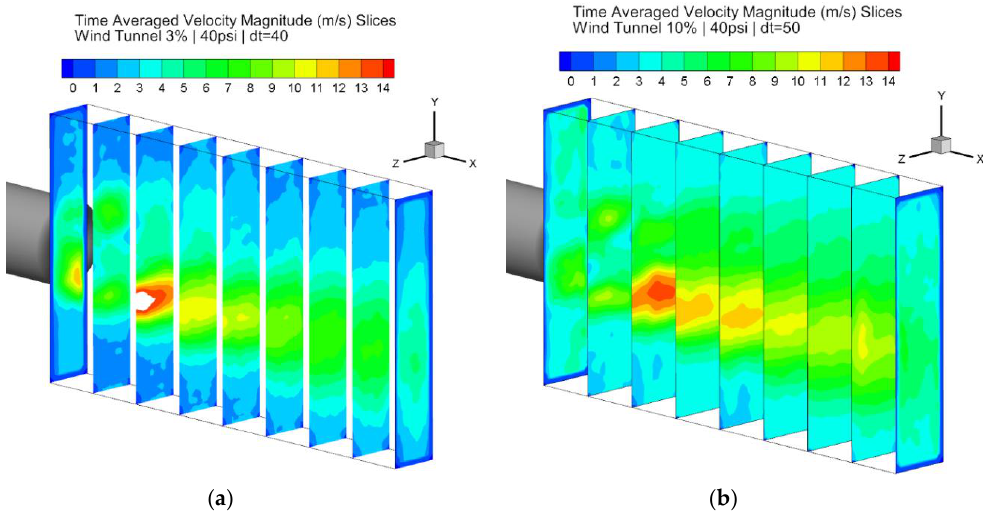
Figure 18. Time-averaged 3D velocity vector contour maps for the stronger 40 psi vortex setting at two freestream conditions: 3% ( a ) and 10% ( b ).